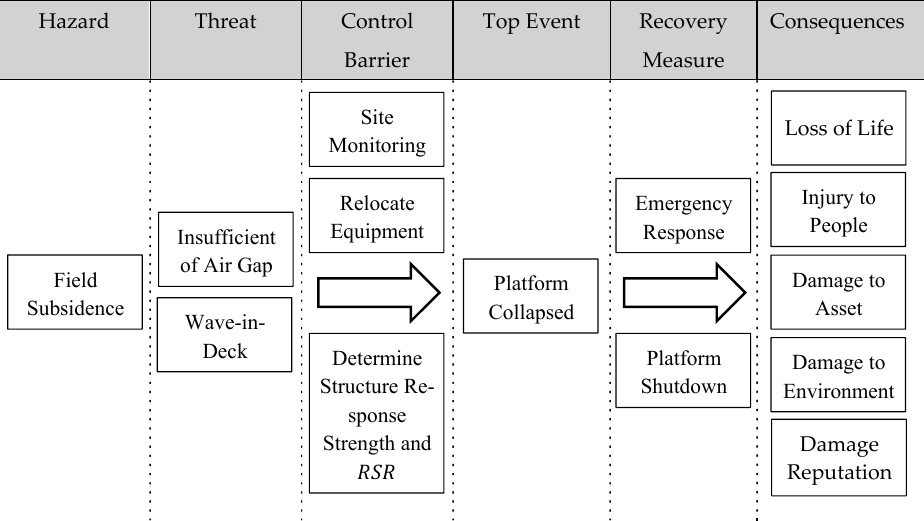
Figure 4. Bow-tie of existing jacket structure with field subsidence issue.